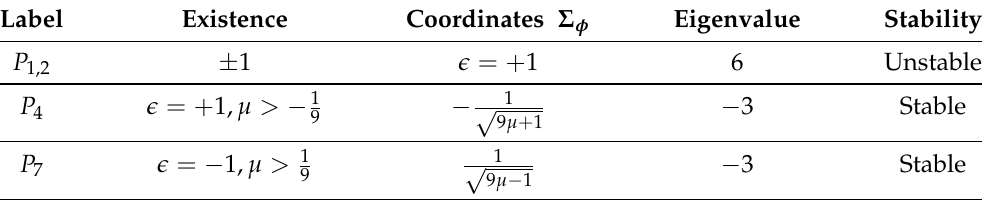
Table 3. Equilibrium points of System (79) for (cid:101) = ± 1 with their eigenvalues and stability.